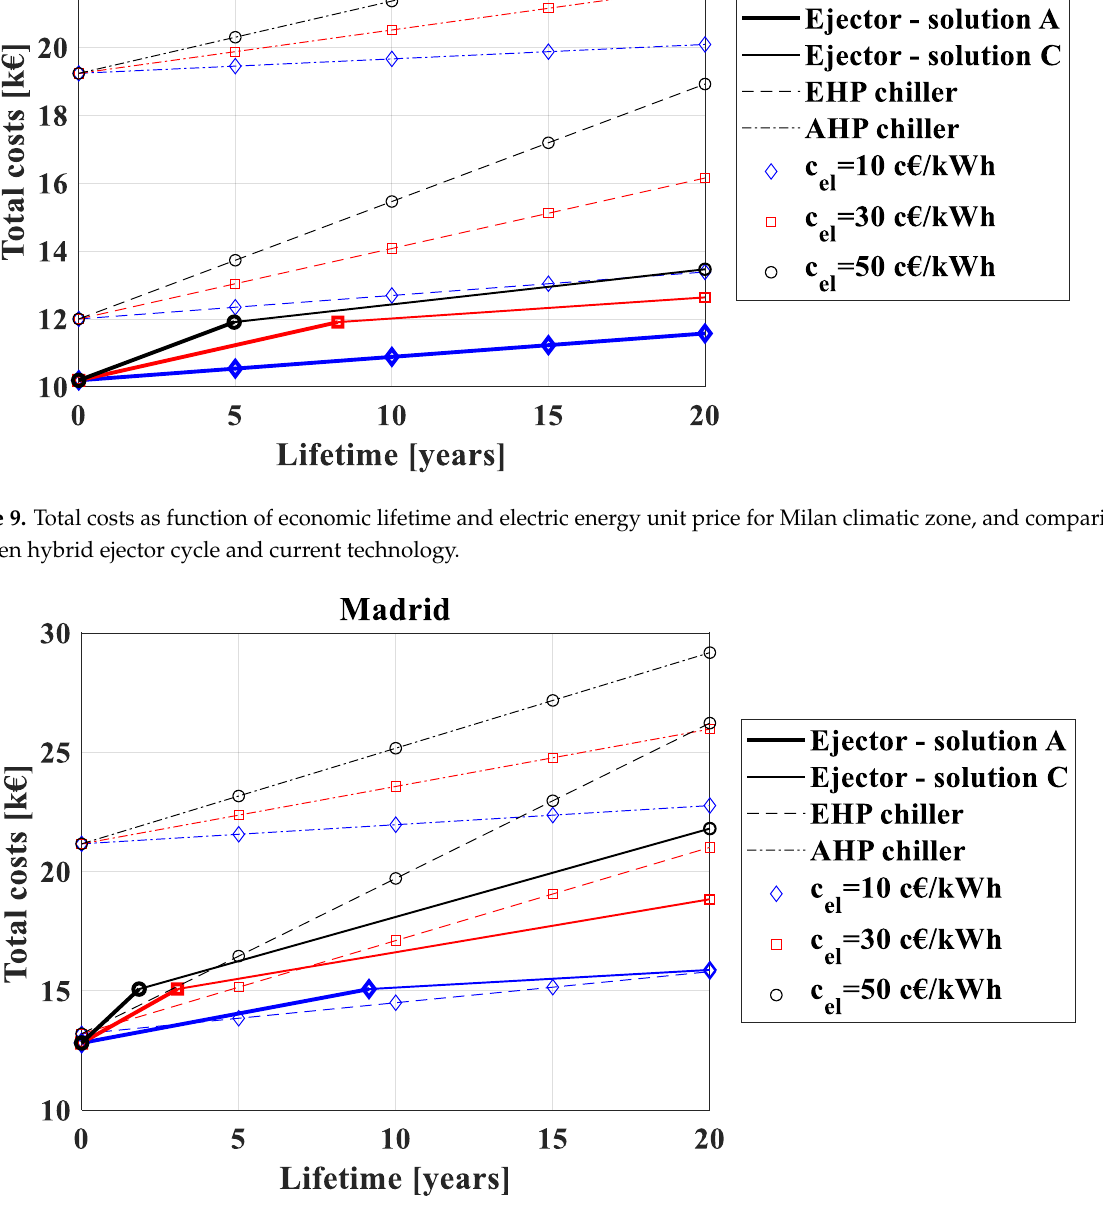
Figure 10. Total costs as function of economic lifetime and electric energy unit price for Madrid climatic zone, and comparison between hybrid ejector cycle and current technology.